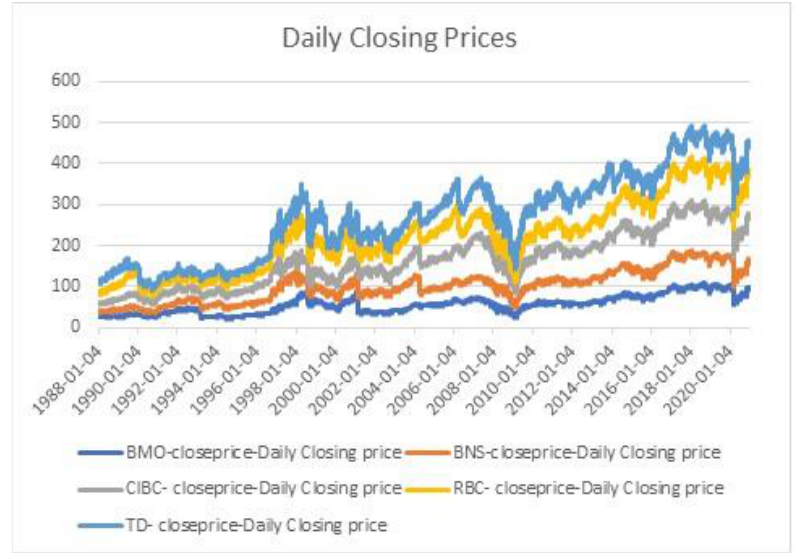
Figure 1. Closing price graphs of the five banks. Source: (Data 1 n.d.) http://clouddc.chass.utoronto. ca.ezproxy.lib.ryerson.ca/ds/cfmrc/displayTSX.do?ed=2018&t=ts&f=daily&lang=en#v2, accessed on 5 May